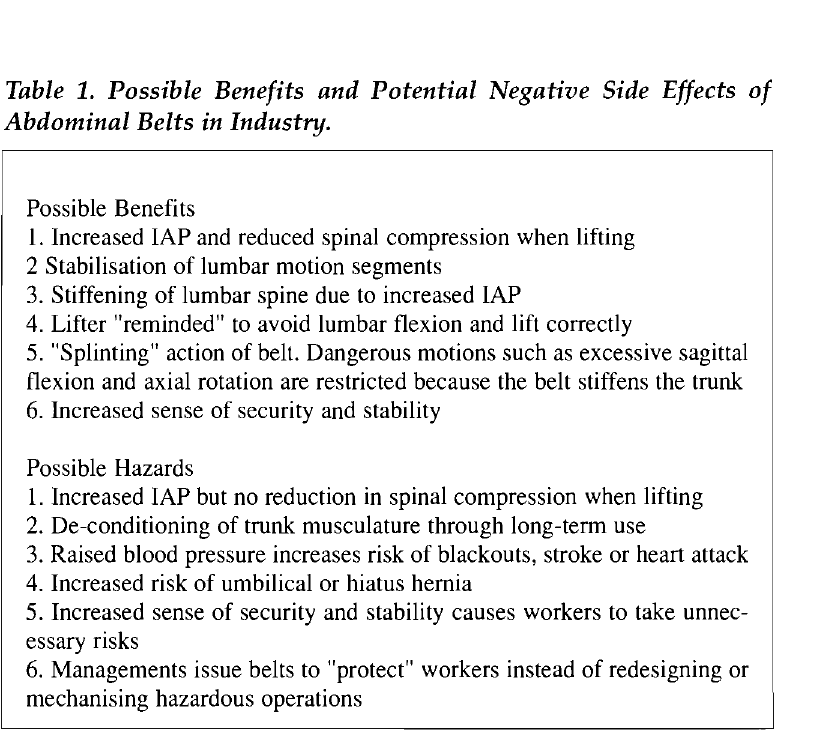
Table 1. Possible Benefits and Potential N egative Side Effects of Abdom inal Belts in